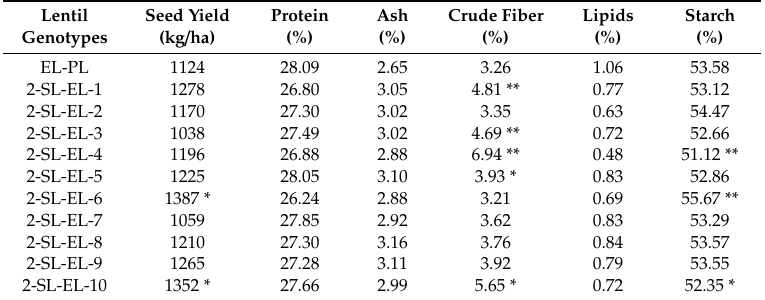
Table 1. Seed yield and nutritional quality seed traits of the parental landrace “Elassona” (EL-PL) and second-generation sister lines (SLs) originating from “Elassona” (EL).